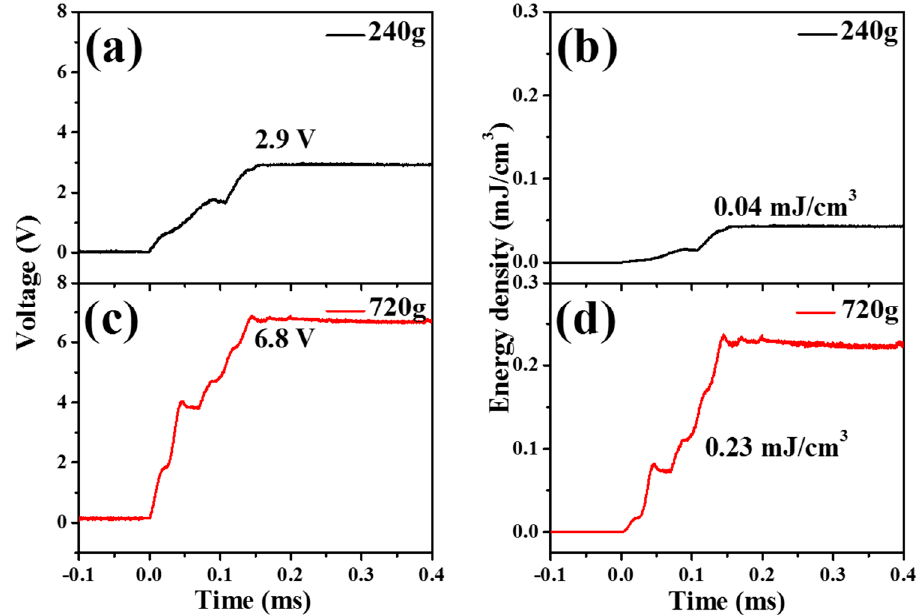
Figure 9. The generated output voltage and energy from piezoelectric energy harvesters with a spring structure. The energy was stored in a 10 µ F capacitor. The generated output voltage of a 240 g weight ( a ), generated energy of a 240 g weight ( b ), generated output voltage of a 240 g weight ( c ), generated energy of a 720 g weight ( d ).